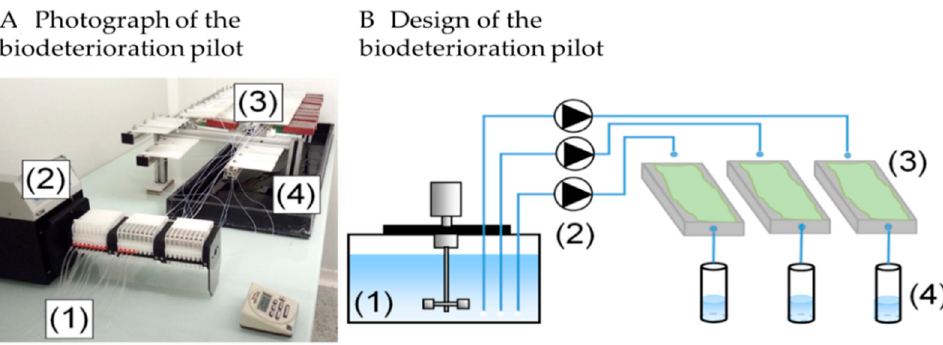
Figure 2. ( A ) Biogenic Acid Concrete (BAC) test pilot; ( B ) Schematic diagram of the BAC test [13].